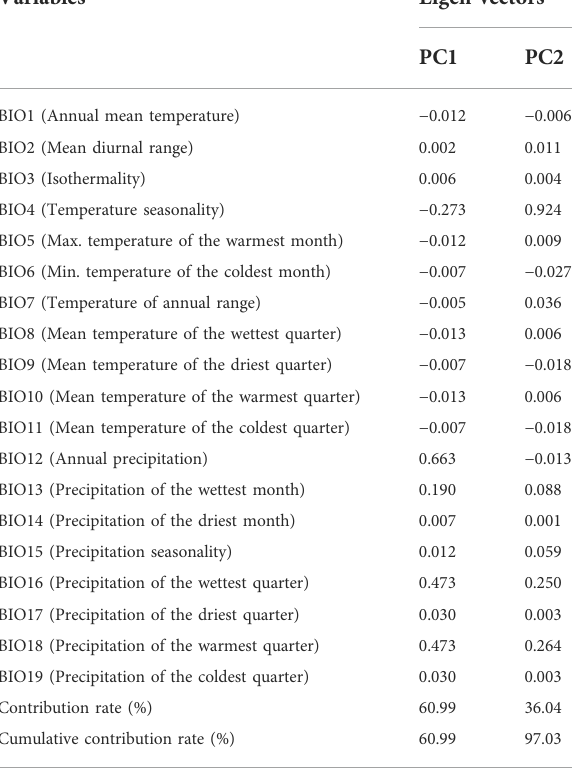
TABLE 1 Principal component analysis of 19 climate factors and eigen values of each